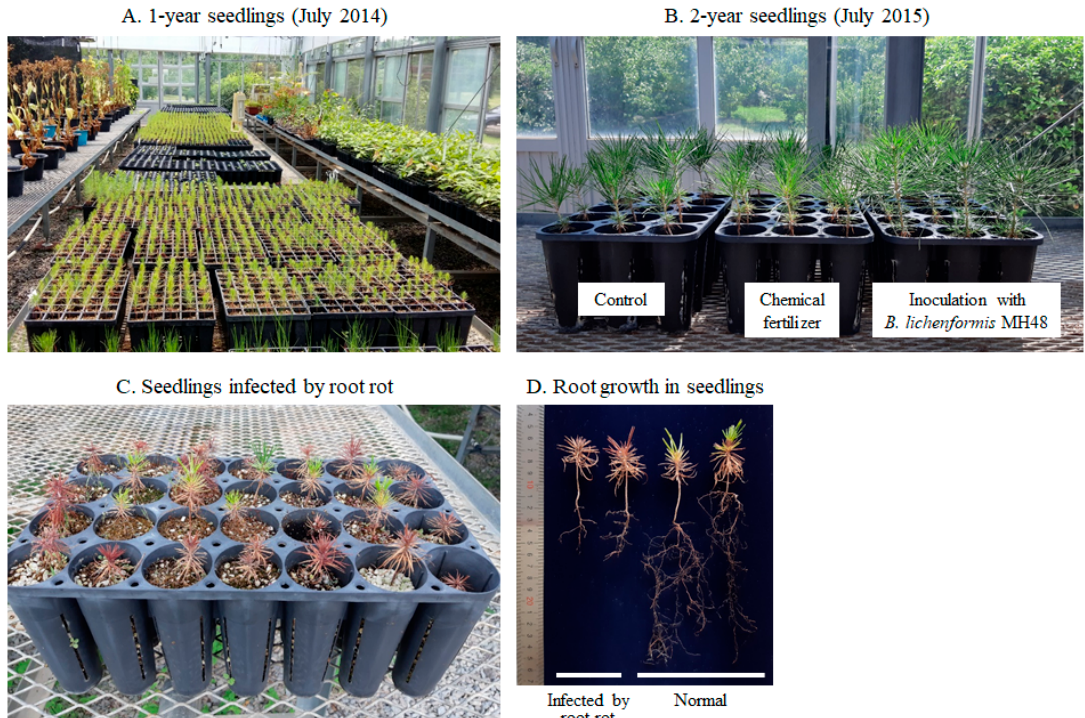
Figure 1. Study area ( A ) and seedling growth ( B ) of coastal pine in an experimental greenhouse at the forest nursery. Seedlings infected with Fusarium root rot wilted and died ( C ), and root growth was reduced ( D ).